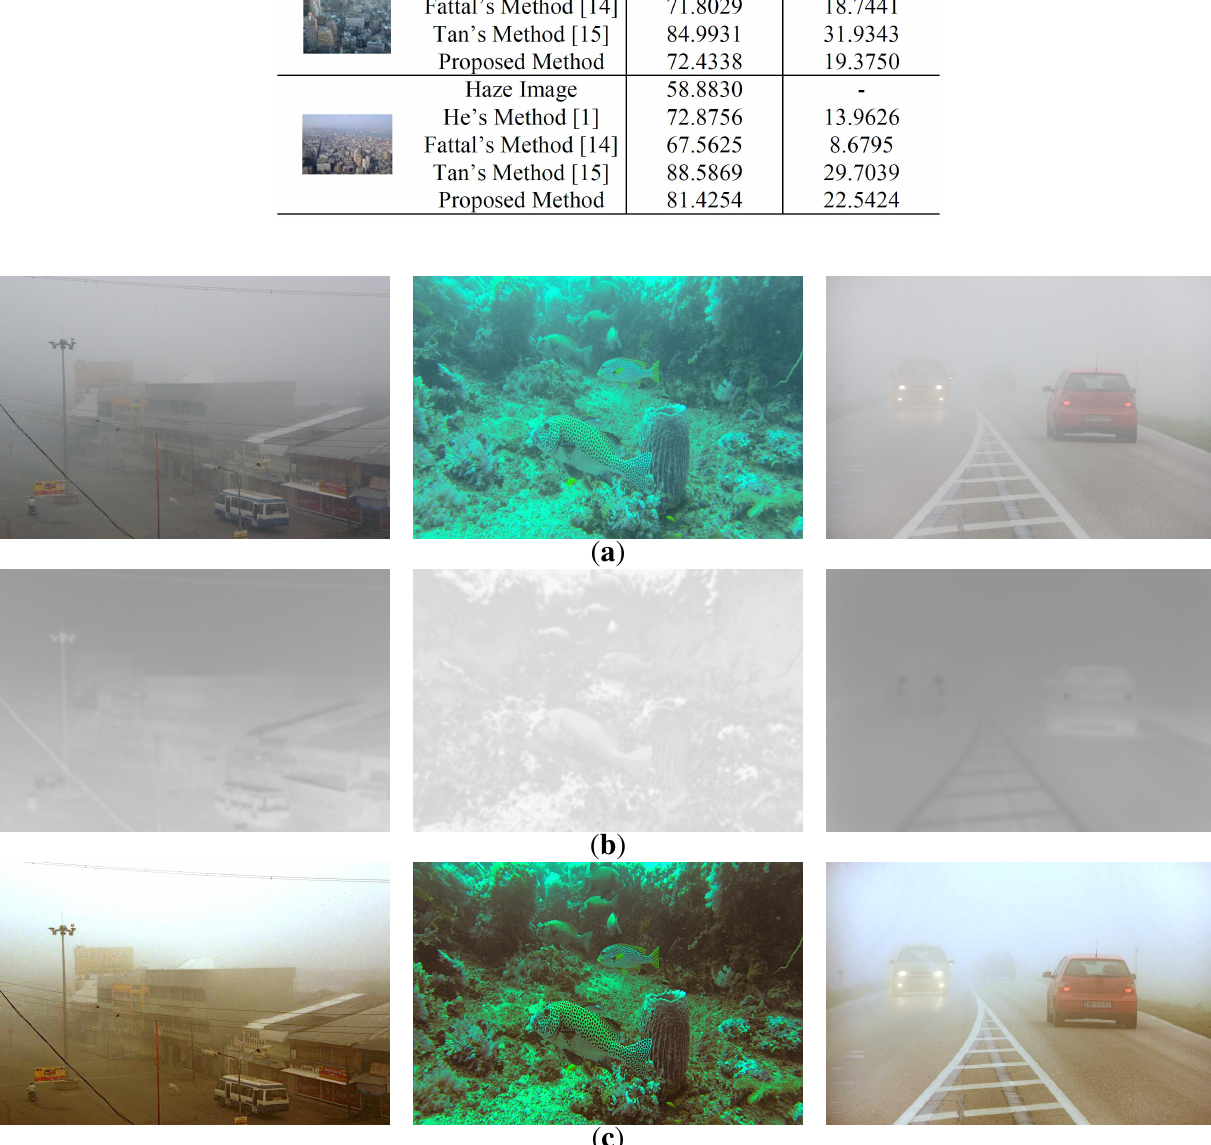
Figure 12. Experimental results of the proposed dehazing method: ( a ) input hazy images acquired by a video surveillance camera, an underwater camera and a vehicle black box camera, respectively; ( b ) the modified transmission maps; and ( c ) the dehazed images using the proposed